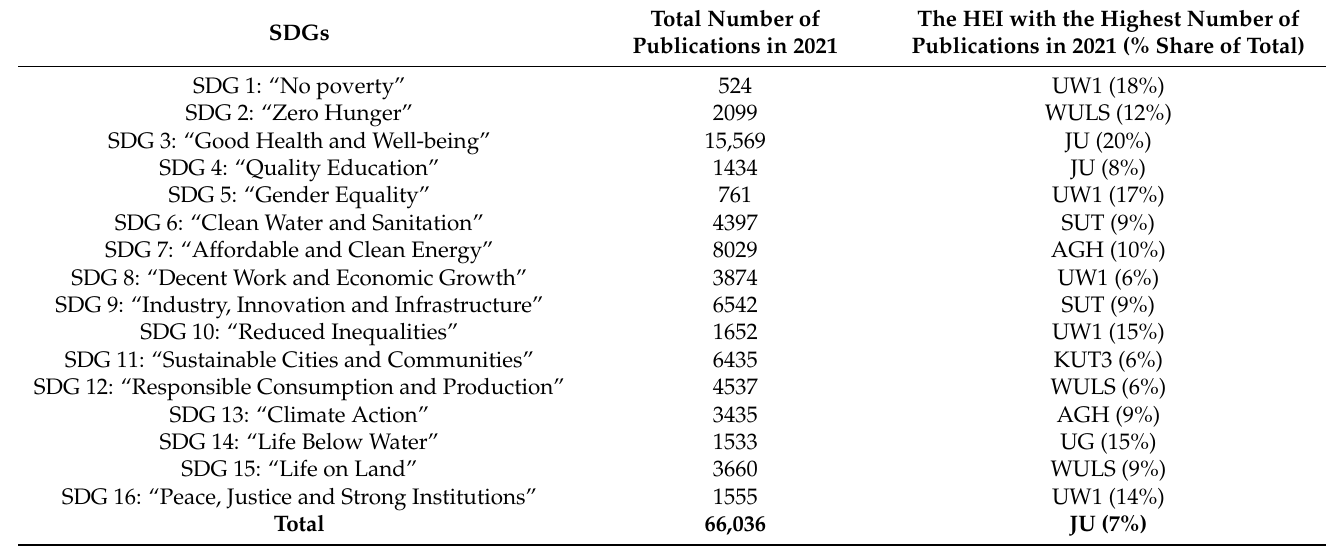
Table 3. Number of publications on the SDGs and the publication leaders in 2021 in